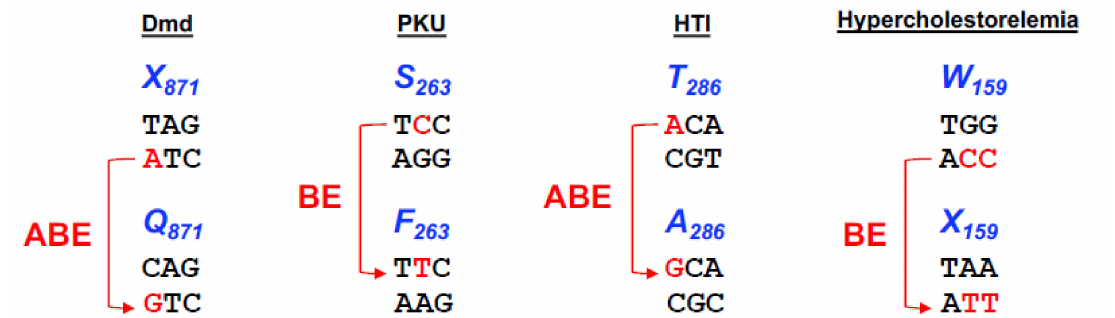
Figure 4. Base editing options to di ff erent diseases. Representation of the four di ff erent codons, X871, S263, T286, W159, responsible for causing Duchenne Muscular Dystrophy (Dmd),